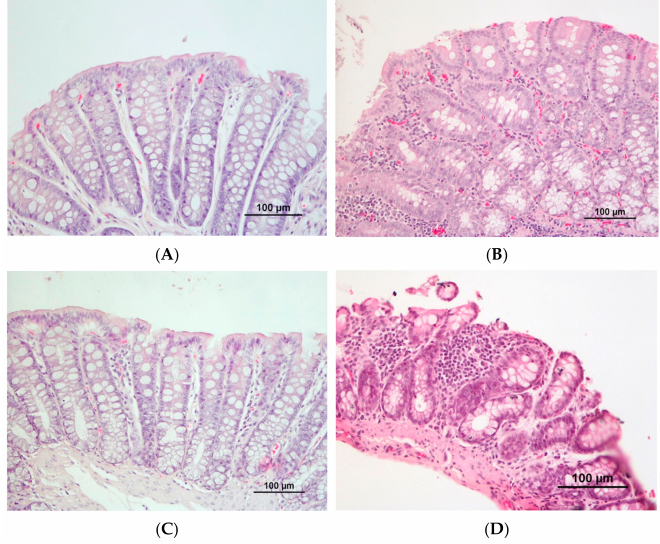
Figure 4. Evaluation of colon inflammation. Colon from controls (( A ), CTRL1, and ( C ), CTRL2) exhibiting a mild inflammatory infiltrate, affecting the mucosa, with no disrupted architectural structure. Colon from CRC animals (( B ), CRC1, and ( D ), CRC2), showing moderate mononuclear inflammatory infiltrate, especially affecting the mucosa, with disruption of architectural structure and erosion (HE